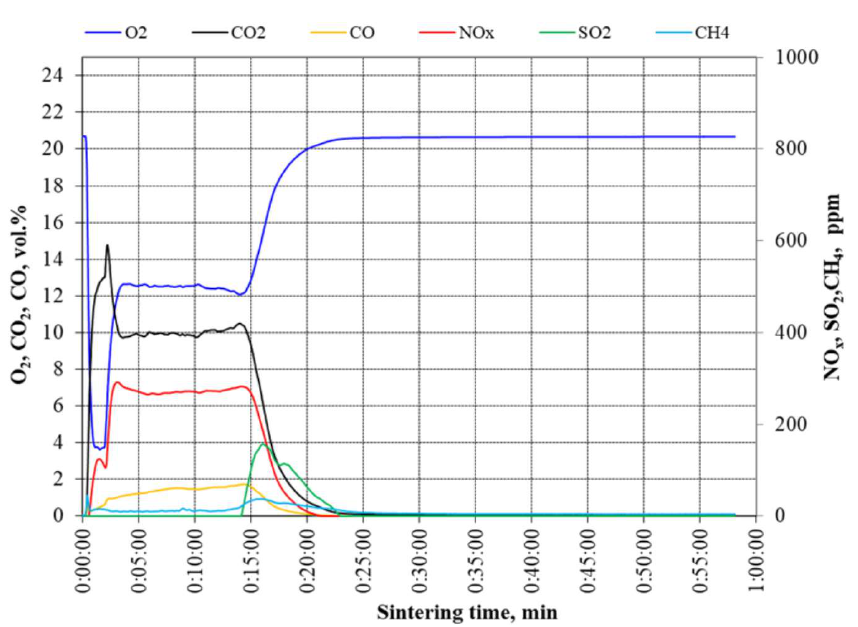
Figure 7. An exemplary composition of exhaust gas on the dirty side during sintering with fuel mixtures with biochar.